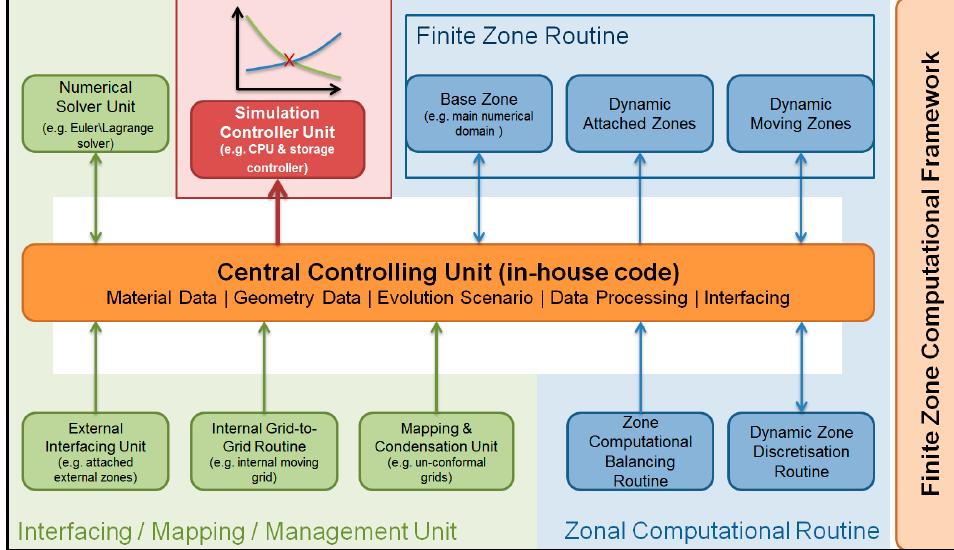
Figure 3. Components of dynamic finite zone computational framework and its central unit.